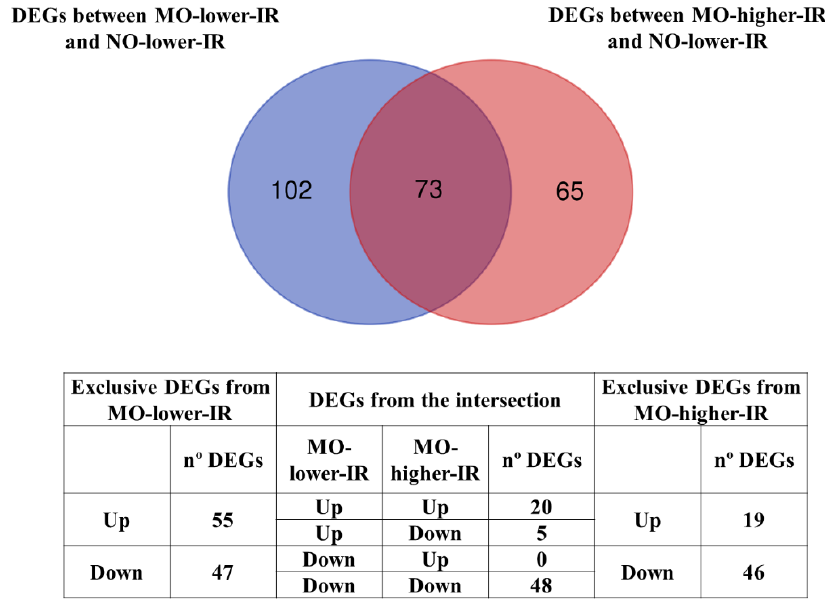
Figure 1. Venn diagram of the differentially expressed genes (DEGs) (FDR < 0.05) in the microarray.